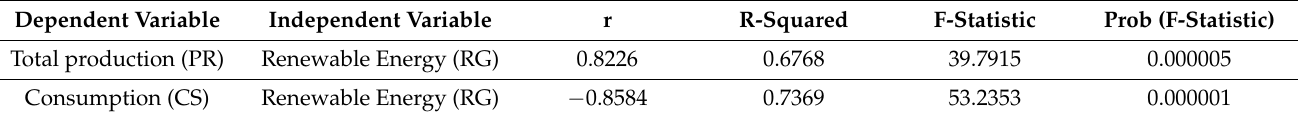
Table 3. Analysis